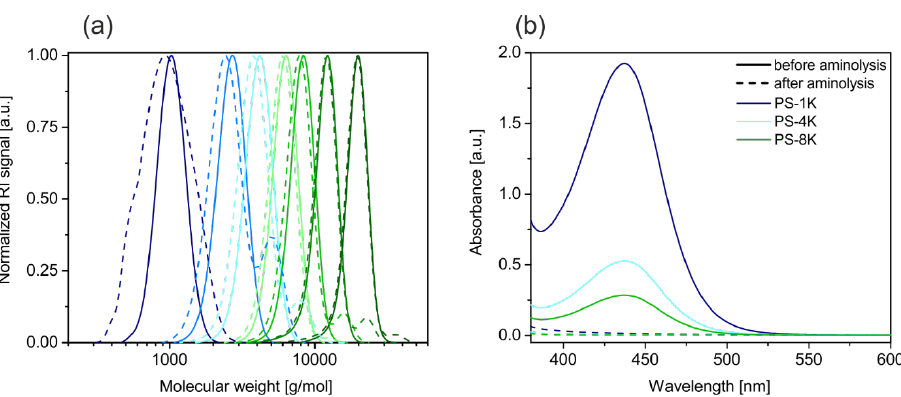
Figure 2. ( a ) Molecular weight distributions of the polystyrene ligands before (solid lines) and after (dashed lines) the aminolysis. ( b ) UV-VIS spectra of the 1 K, 4 K, and 8 K ligands before (solid lines) and after (dashed lines) the aminolysis. The absence of the n → π* transition proves the successful reaction. The absorbance decreases with increasing molecular weight, which correlates well to the ratio between trithiocarbonate end-groups and the ligand length.